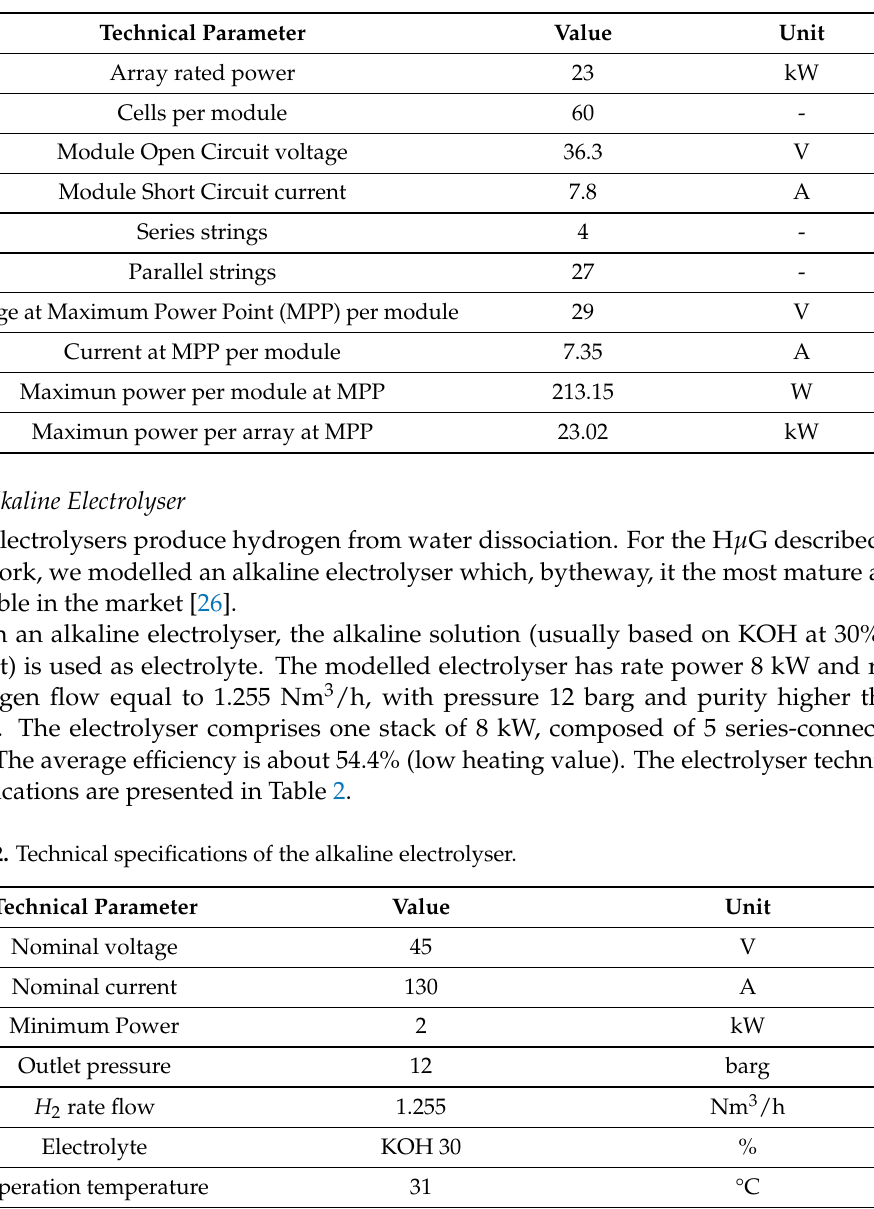
Table 1. Technical specifications of the PV system.